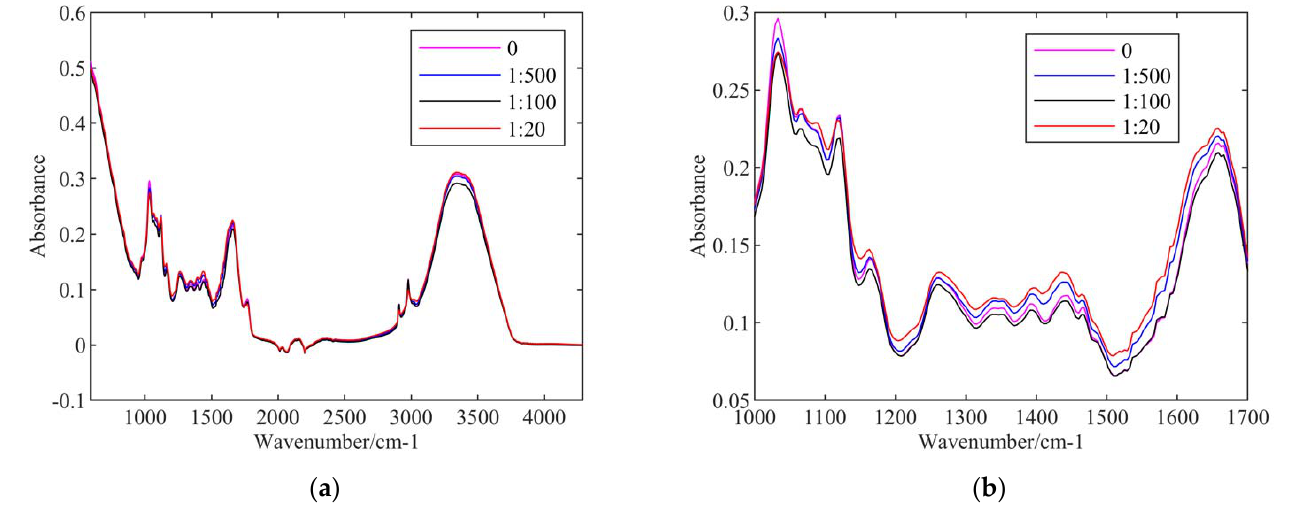
Figure 1. ( a ) Average spectra of four groups of samples; ( b ) Partially enlarged area of the average spectra. Figure 2 compares the original data and the data processed by MSC.